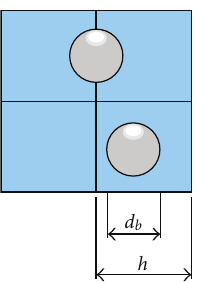
Figure 1: Milelli condition (from Niceno et al.